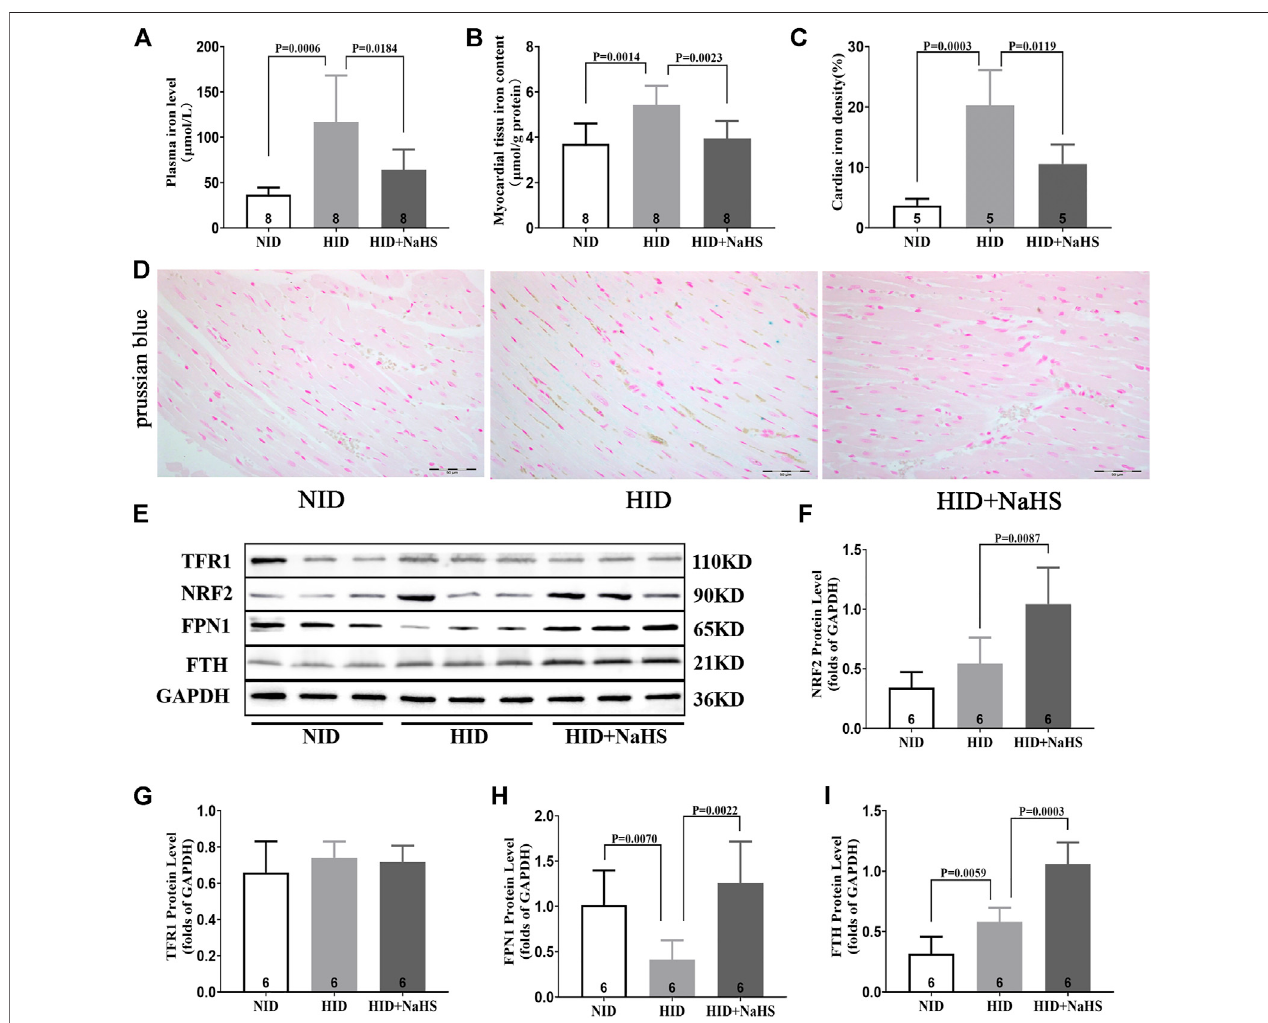
FIGURE9| H 2 SregulatedcardiomyocyteironmetabolisminratsfedwithHID. (A) IronlevelsintheplasmaofHIDrats. (B) IronlevelsinthemyocardialtissueofHID rats. (C) Quantitative data on Prussian-blue staining in HID rats. (D) Representative Prussian-blue staining in myocardial tissue sections of HID rats. (E) Representative Western blots for TFR1, NRF2, FPN1, and FTH expressions in the myocardial tissues of HID rats. GAPDH was used as the internal control. (F) Quantitative analysis for NRF2expressioninthemyocardialtissueofHIDrats. (G) QuantitativeanalysisfortheTFR1expressioninthemyocardialtissueofHIDrats. (H) Quantitativeanalysis for the FPN1 expression in the myocardial tissue of HID rats. (I) Quantitative analysis for the FTH expression in the myocardial tissue of HID rats. Results are means ± SEM. A p -value of < 0.05 was considered signi fi cant.